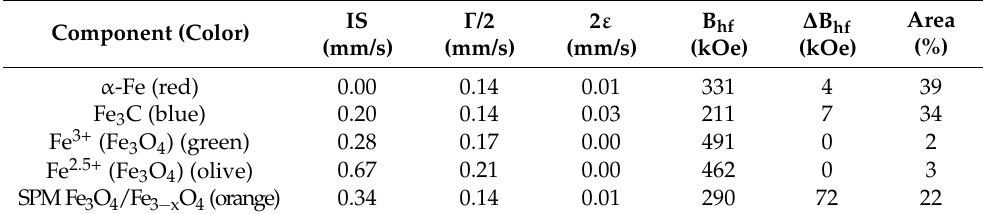
Figure 6. Room temperature 57 Fe Mössbauer spectrum of NaPA@MAC hybrid. Color curves are defined in Table 3. Table 3. 57 Fe Mössbauer hyperfine parameters resulting from the best fits of the corresponding spectrum of NaPA@MAC sample recorded at 300 K. IS is the isomer shift (given relative to α -Fe at 300 K), Γ /2 is the half line-width, 2 ε is the quadrupole shift, B hf is the central value of the hyperfine magnetic field, ∆ B hf is the spreading of B hf , and Area is the relative spectral absorption area of each component used to fit the spectrum. Typical errors are ± 0.02 mm/s for IS, Γ /2, and 2 ε , ± 3 kOe for B hf and ± 5% for